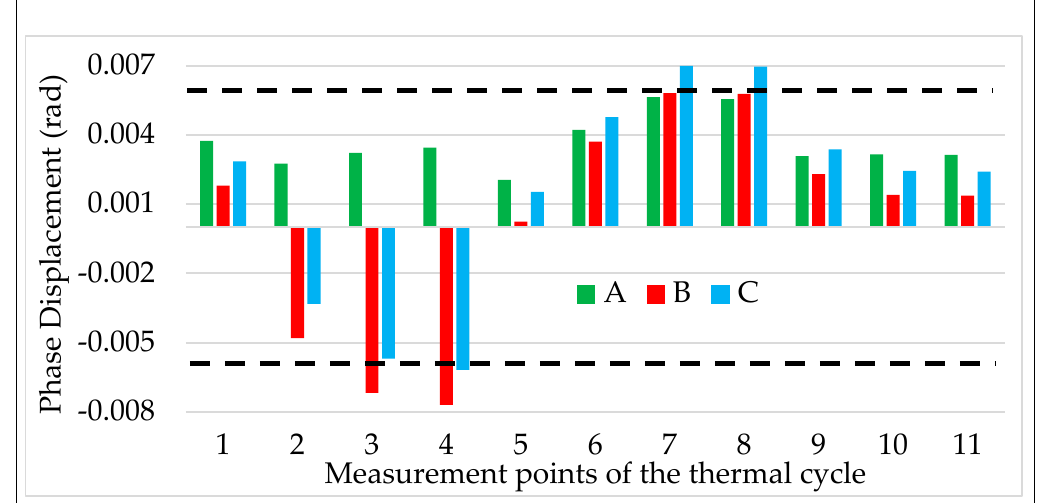
Figure 10. Phase displacement vs. temperature for the three LPVTs under test. The two graphs contain three colored bars for each measurement point from #1 to #11. Each bar corresponds to one LPVT from A to C, green, red, and light blue, respectively. Finally, to better assess the results, dashed lines are included in each graph corresponding to the limits of ε and ∆ ϕ fixed by the accuracy class (which is 0.5) of the LPVTs under test.